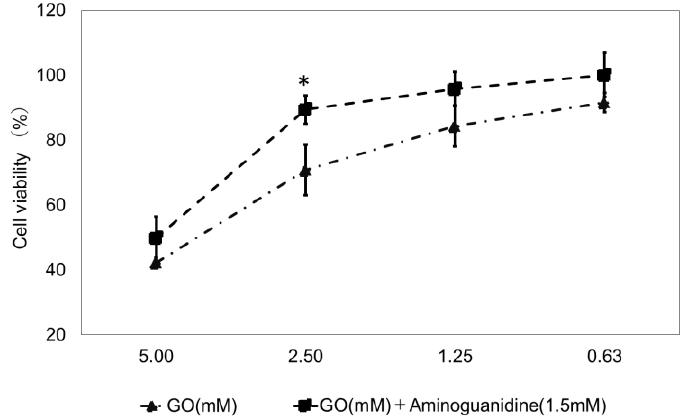
Figure 5. Cell viability of cells exposed to glyoxal (GO) at 24 h of culture. A total of four GO concentrations of 5 mM, 2.5 mM, 1.25 mM, and 0.625 mM were studied, and their effect on cell viability is shown. n = 3, GO: Glyoxal (mM); aminoguanidine: positive control (1.5 mM). The bars represent the mean + SD; * p < 0.05 versus GO; student t -test.